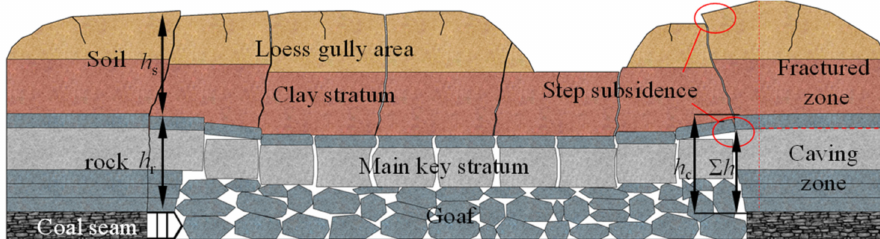
Figure 3. The main key stratum is located in the caving